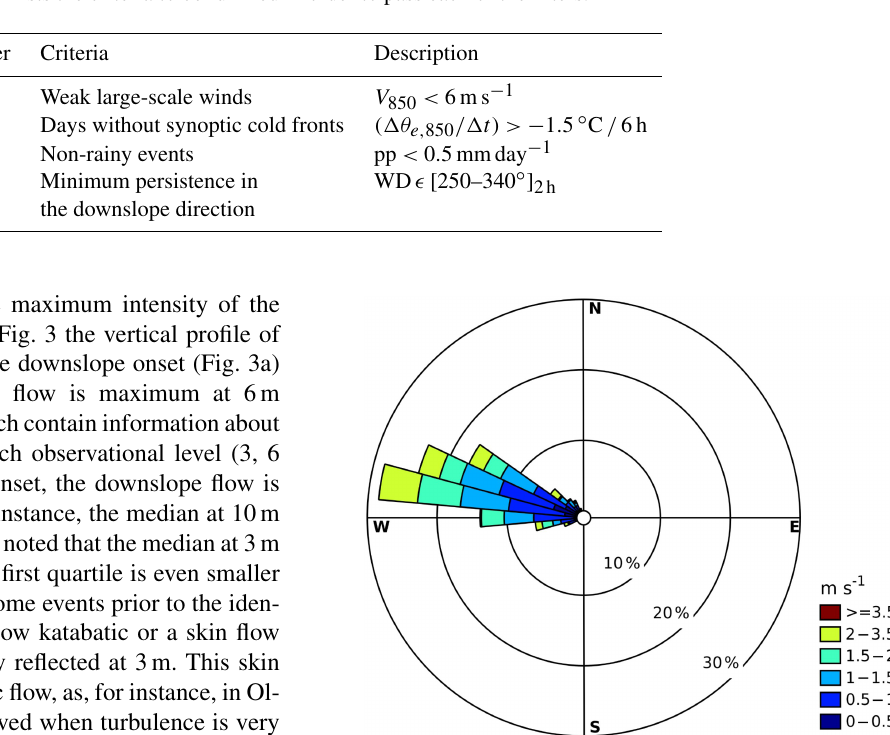
Table 2. Algorithm for thermally driven downslope criteria. First column indicates the filter number; second column shows the physical description of the filter; third column lists the criteria to be fulfilled in order to pass each of the filters.